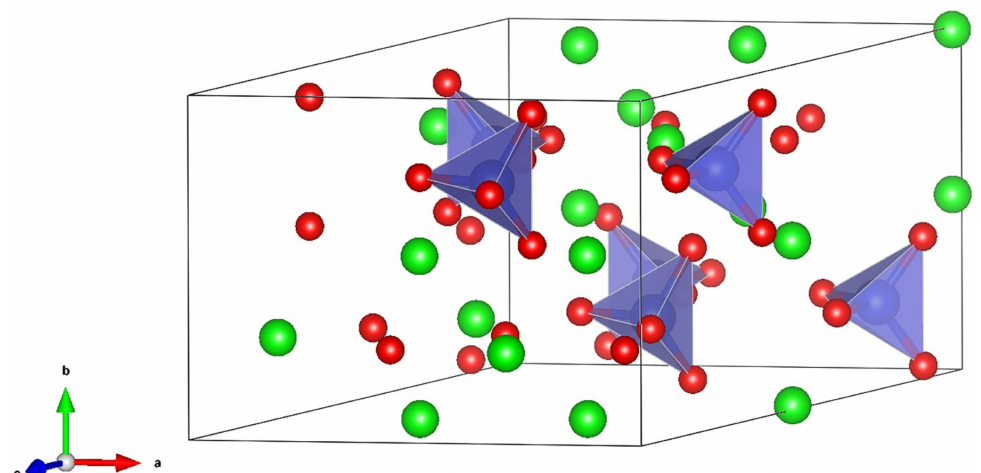
Figure A1. Structure of unit cell of M3-C 3 S. Green spheres indicate Ca; red spheres indicate O; blue spheres indicate Si in the center of the tetrahedron.